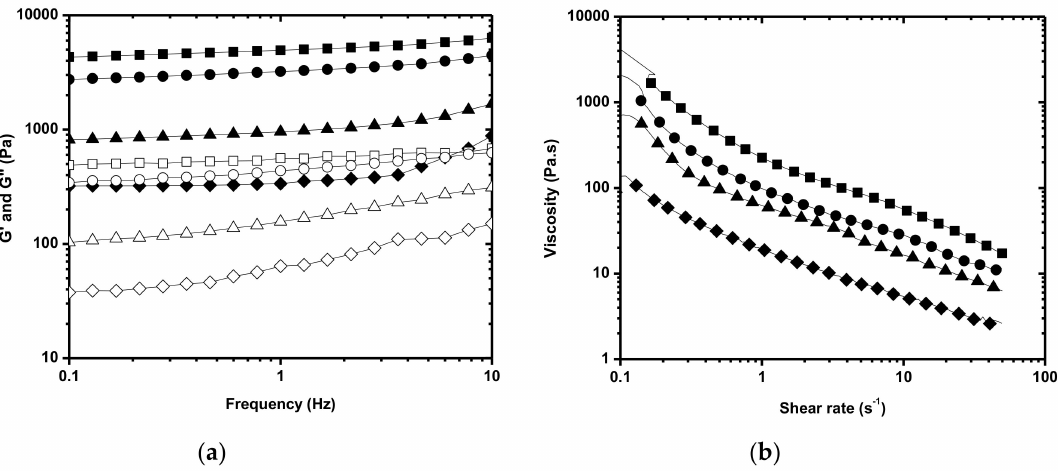
Figure 2. Rheological behavior of MP AHA and MP AHA-CHT as a function of the mass ratio. ( a ) Oscillation spectrum and ( b ) Flow curve. ( (cid:7) ) MP AHA, ( (cid:78) ) MP AHA-CHT 90:10 , ( (cid:8) ) MP AHA-CHT 75:25 , and ( (cid:4) ) MP AHA-CHT 50:50 . G’ (closed symbol), G” (open symbol).